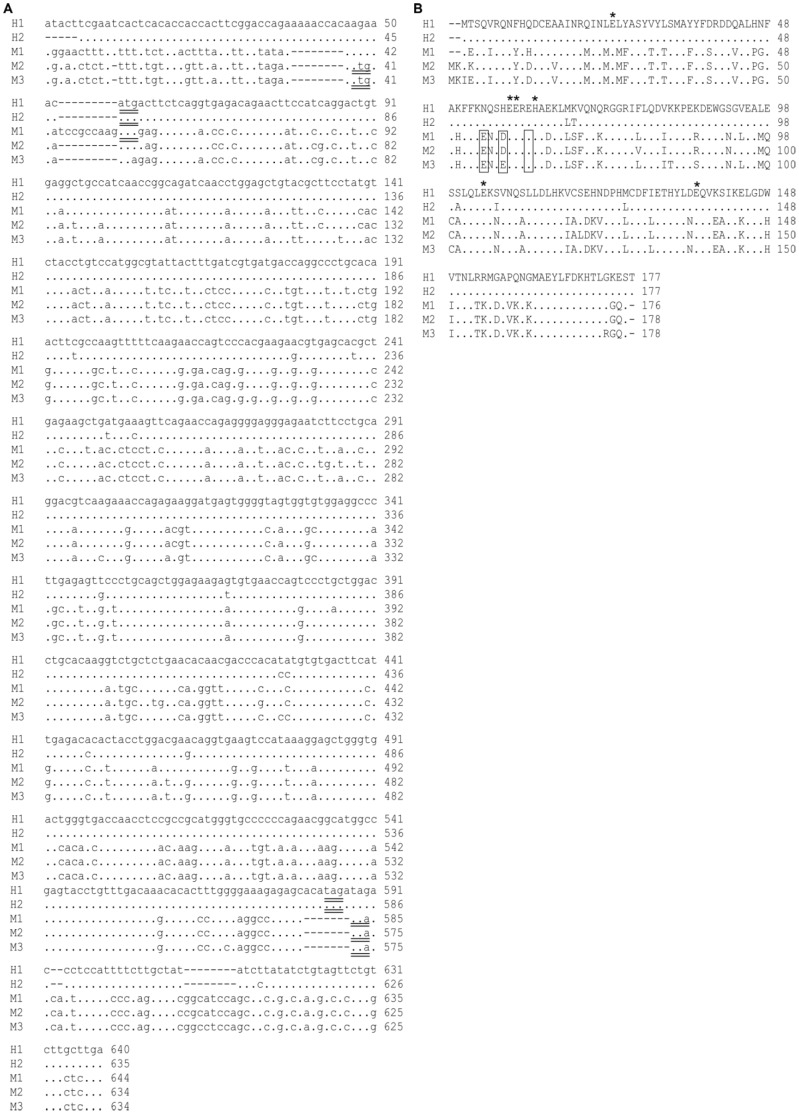
Nucleotide sequences of the Atlantic salmon ferritin cDNAs A) Nucleotide sequences of the Atlantic salmon ferritin cDNA clones H1, H2, M1, M2 and M3.Identical nucleotide residues are indicated by periods, while substituted residues are shown. The start and termination codons are underlined. B) Amino acid sequences based on the predicted ORFs of H1, H2, M1, M2 and M3. Identical amino acid residues are indicated by periods and substituted residues are shown. The conserved ferroxidase centres and nucleation sites are respectively indicated by * and boxes.